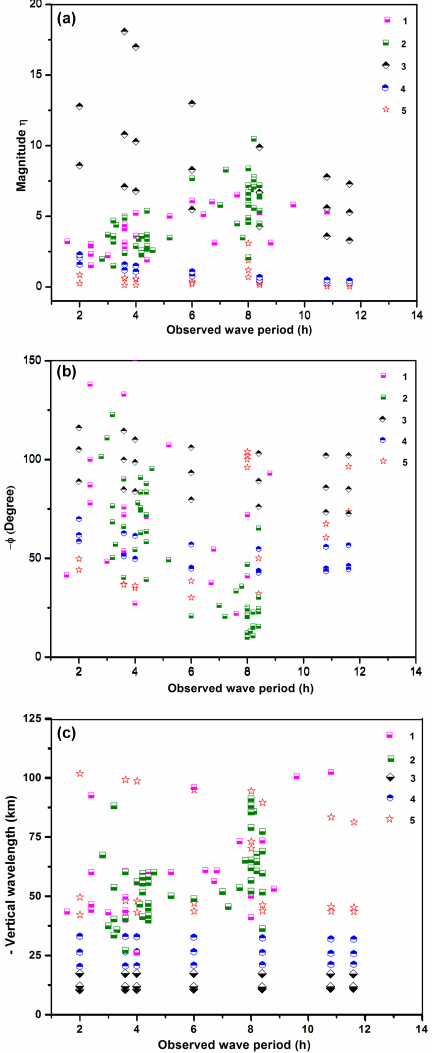
Figure 3. (a) Comparison with η calculated by observation of both years and full-wave model simulation with their respective wave period. Pink and green lower half-filled squares show the year 2010 and 2011 η observations: (1) and (2) – present study η ; (3) FWM simulation of η for 50ms − 1 horizontal phase velocity; (4) FWM simulation of η for 100ms − 1 horizontal phase velocity; and (5) FWM simulation of η for 150ms − 1 horizontal phase velocity). (b) Similar to (a) but for phase values for both the short- and long- period wave. (c) Similar to (a) but for deduced vertical wavelength (VW).